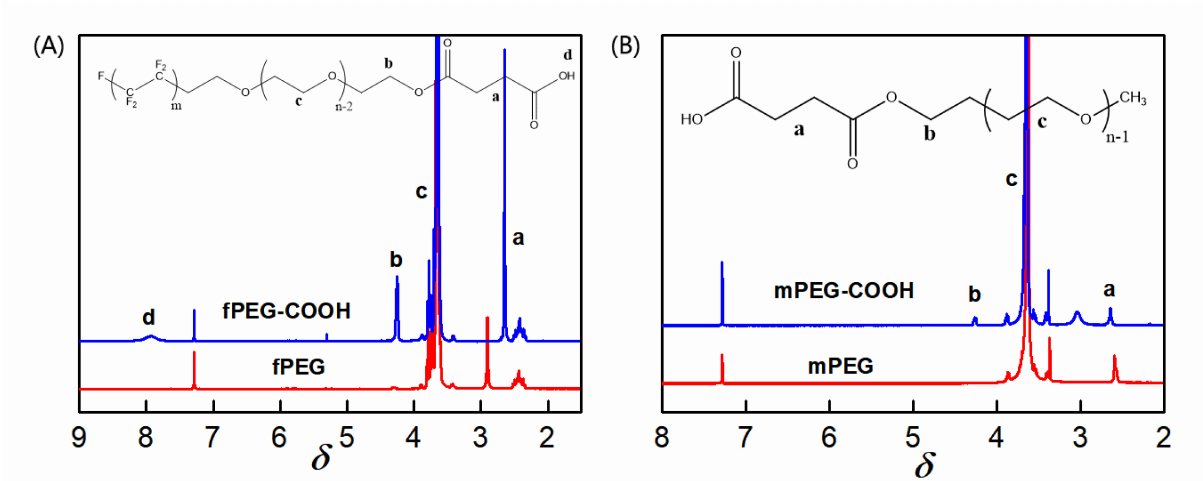
Figure 4. ( A ) The 1 H-NMR spectra of fPEG and fPEG-COOH; a–d are represents different proton peaks in the chemical structure of fPEG-COOH molecule; ( B ) the 1 H-NMR spectrum of mPEG and mPEG-COOH; a–c are represents different proton peaks in the chemical structure of mPEG-COOH